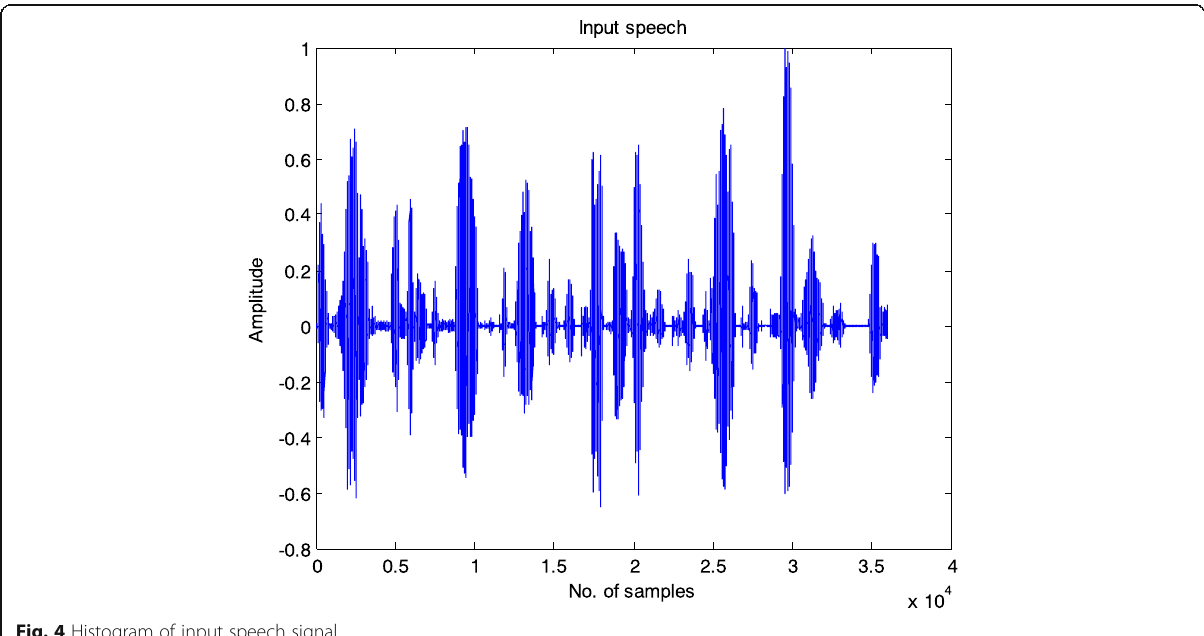
Fig. 4 Histogram of input speech signal